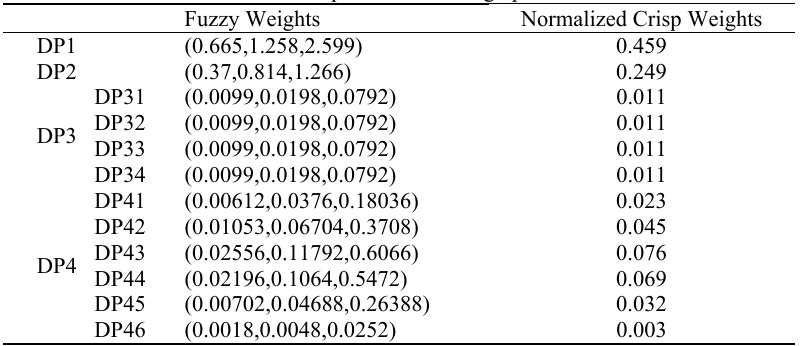
Table 3. The importances of design parameters